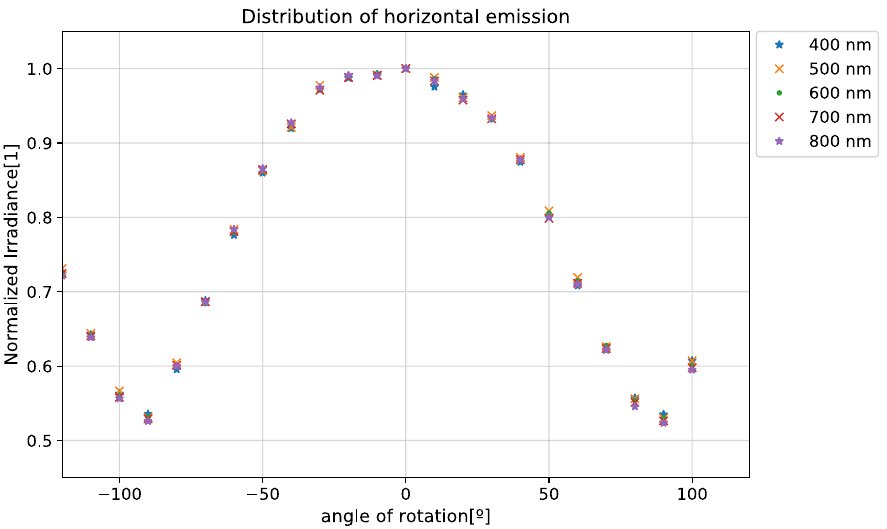
Fig. 9 Distribution of radiant exitance of the 100 W halogen lamp on the horizontal plane. The irradiance was measured at steps of